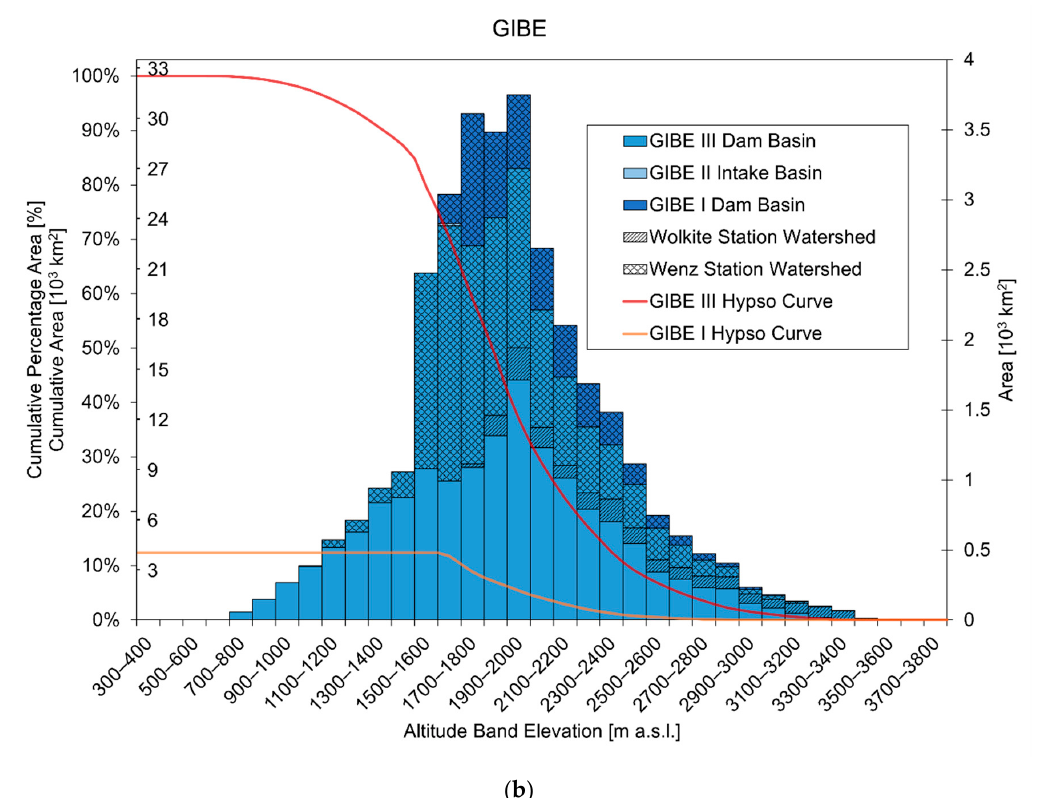
Figure 2. Hypsographic curve at dam sites. ( a ) Grand Ethiopian Renaissance Dam (GERD) and ( b ) GIBE.